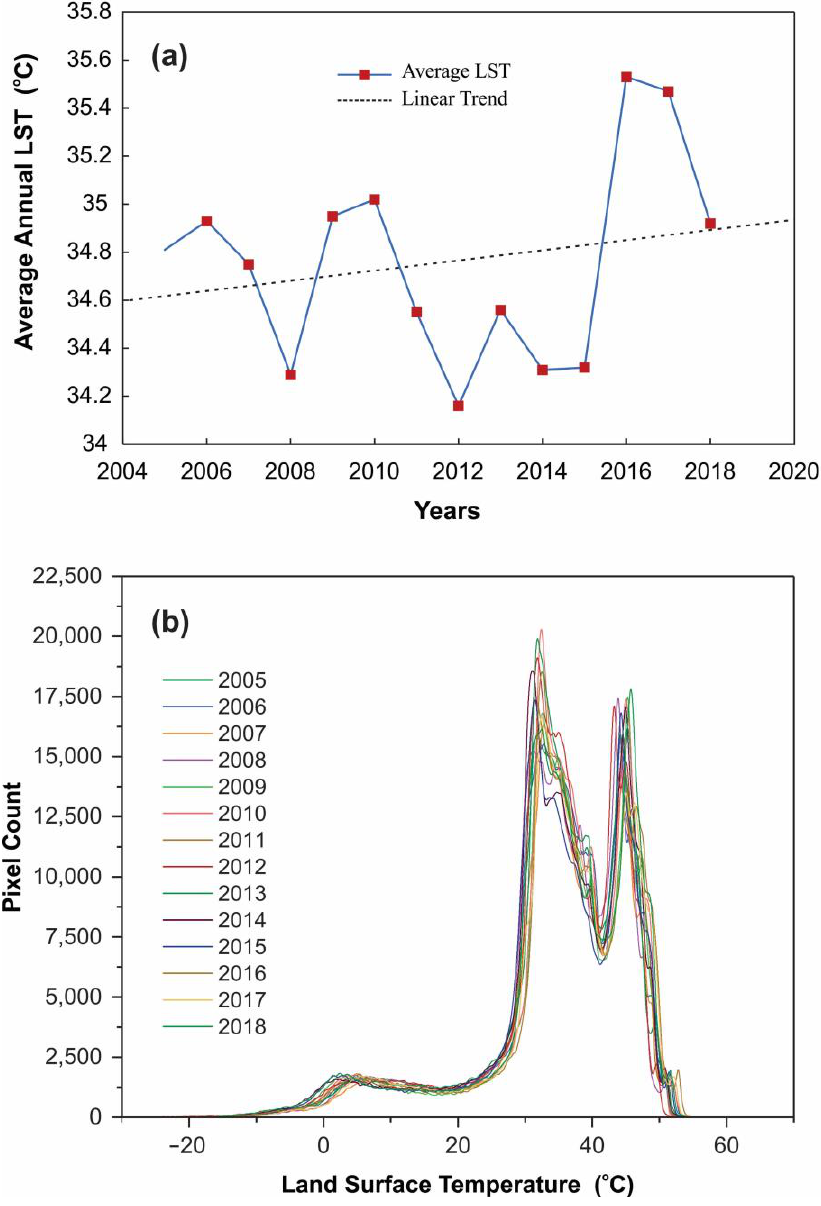
Figure 12. Interannual Mean LST, including its frequency histogram for the years of 2005 to 2018 throughout the Pakistan.